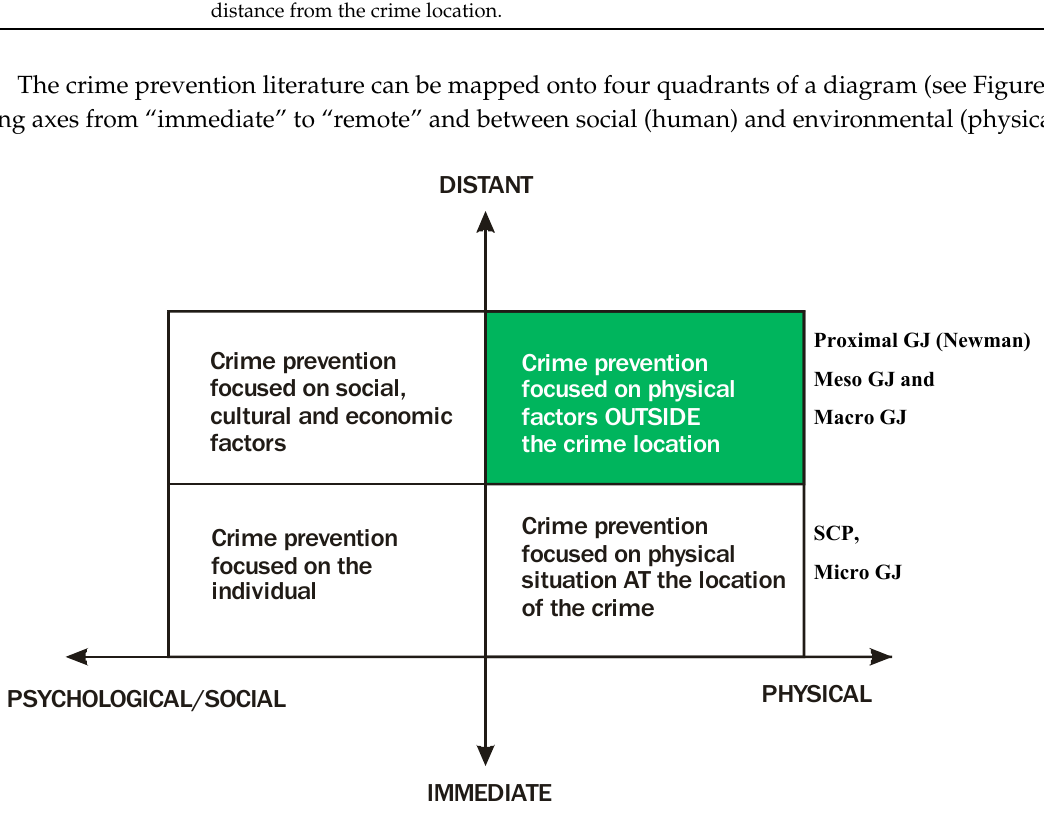
Figure 1. Geographical juxtaposition and the crime prevention literature.